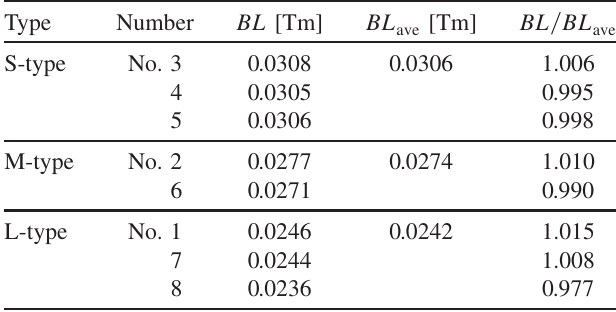
TABLE III. Measured absolute BL values at x ¼ 0 . BL ave is the averaged BL value for the same type of the